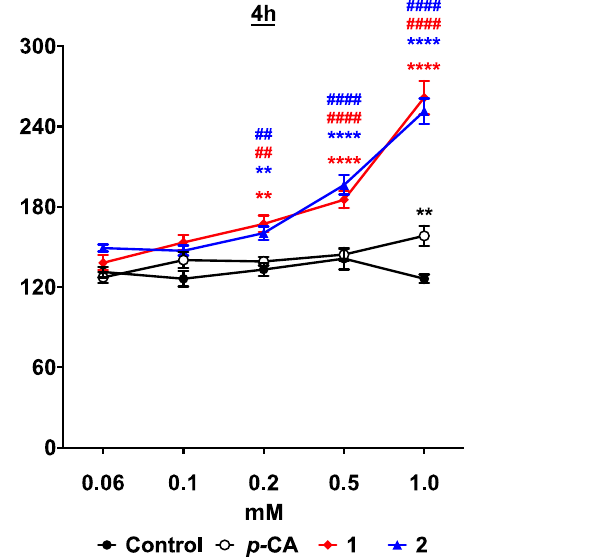
Figure 1. p -Coumaric acid esterification improves the cytotoxicity against the B16-F10 melanoma cells. Murine B16-F10 melanoma cells were incubated with different concentrations of p -coumaric acid ( p -CA, white circles), ethyl p -coumarate ( 1 , red lozenges), or n -butyl p -coumarate ( 2 , blue trian- gles) for 4 h or 24 h. Control cells were incubated with the equivalent concentrations of DMSO. ( A , C ): LDH quantification in culture supernatants; ( B , D ): frequency of viable cells. * p < 0.05, ** p <